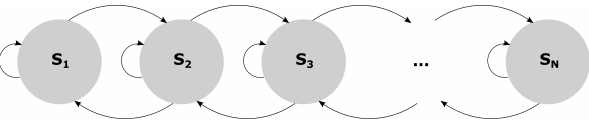
Figure 23. The ergodic chainworld.